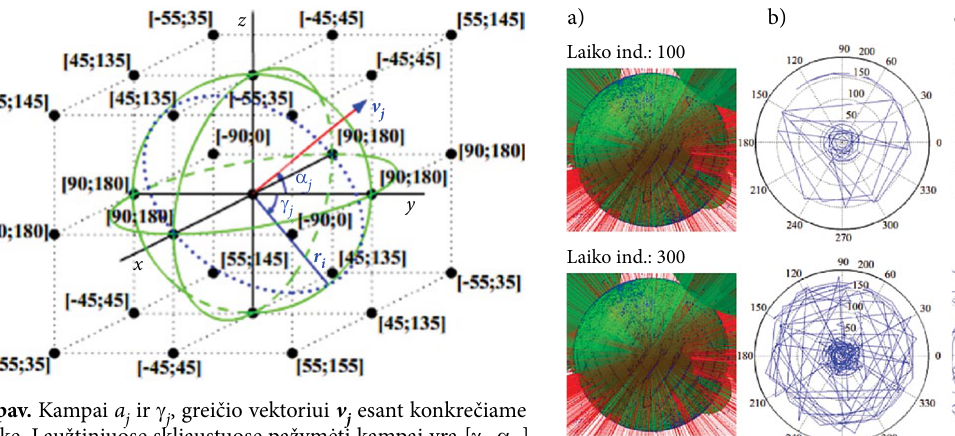
is on a j , a j j